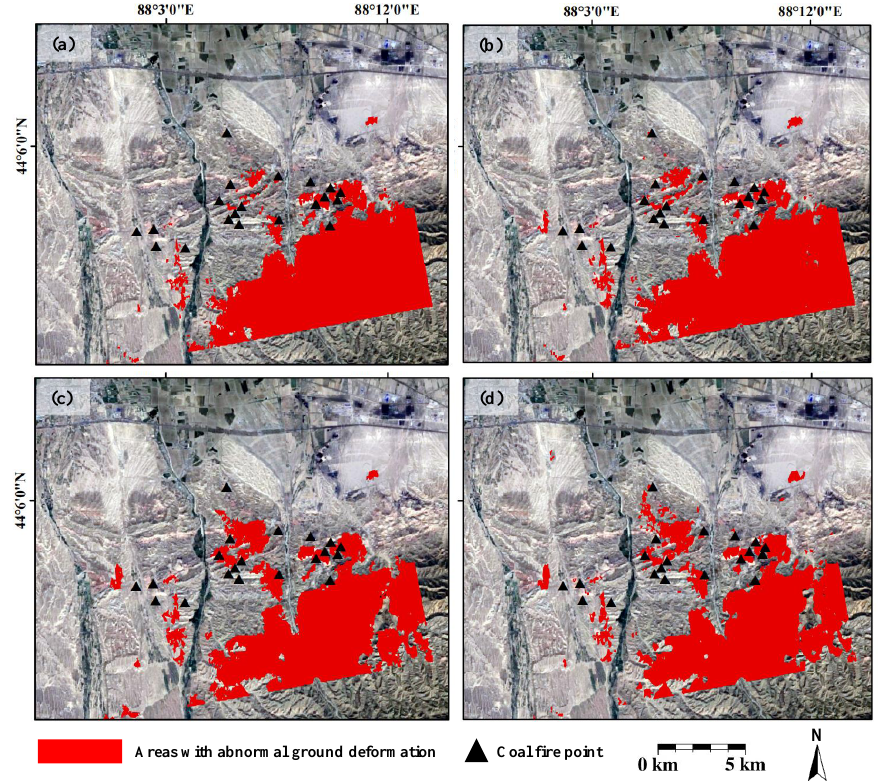
Figure 12. Areas with abnormal ground deformation. ( a – d ) are the divided results of Original Stacking-InSAR, Original ERA5-Corrected Stacking-InSAR, Effective ERA5-Corrected Stacking- InSAR and adaptive ERA5-Corrected Stacking-InSAR,